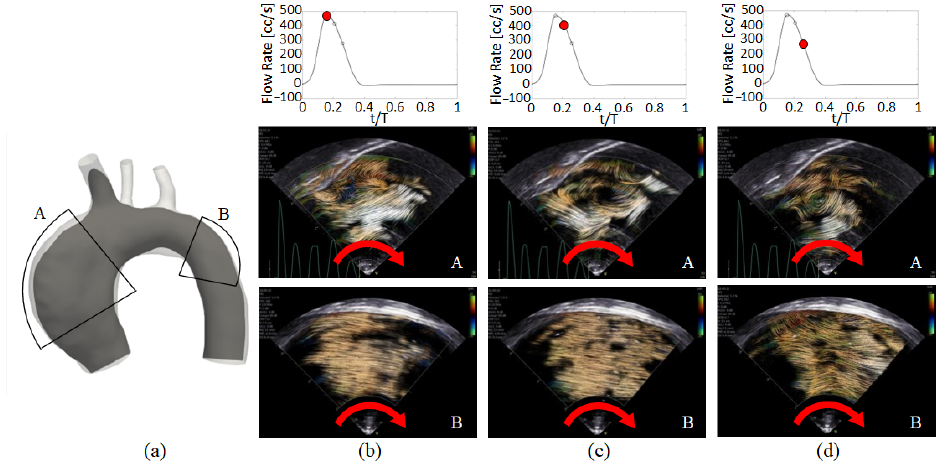
Figure 7. ( a ) Sketch of the aneurysmatic aorta geometry (light gray) and of its sagittal plane (dark gray). Echographic results at ( b ) t / T = 0.156, ( c ) t / T = 0.208, and ( d ) t / T = 0.260.